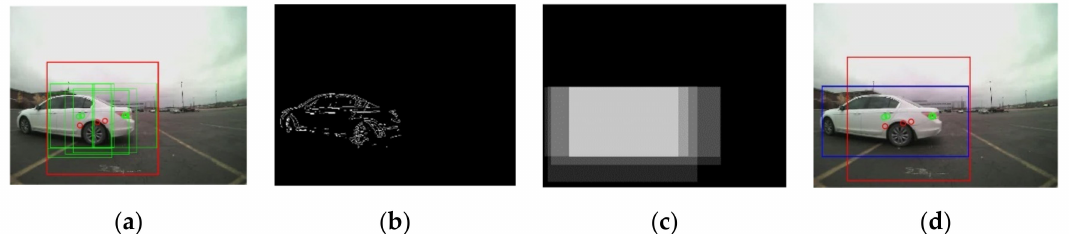
Figure 7. The proposed ROI generation algorithm: ( a ) the green bounding boxes are generated from the radar signals, the merged ROI is presented with the red square; ( b ) the first gradient of the motion image after binarization; ( c ) the temporal correlation map; ( d ) redefined ROI in the blue rectangular using the temporal correlation